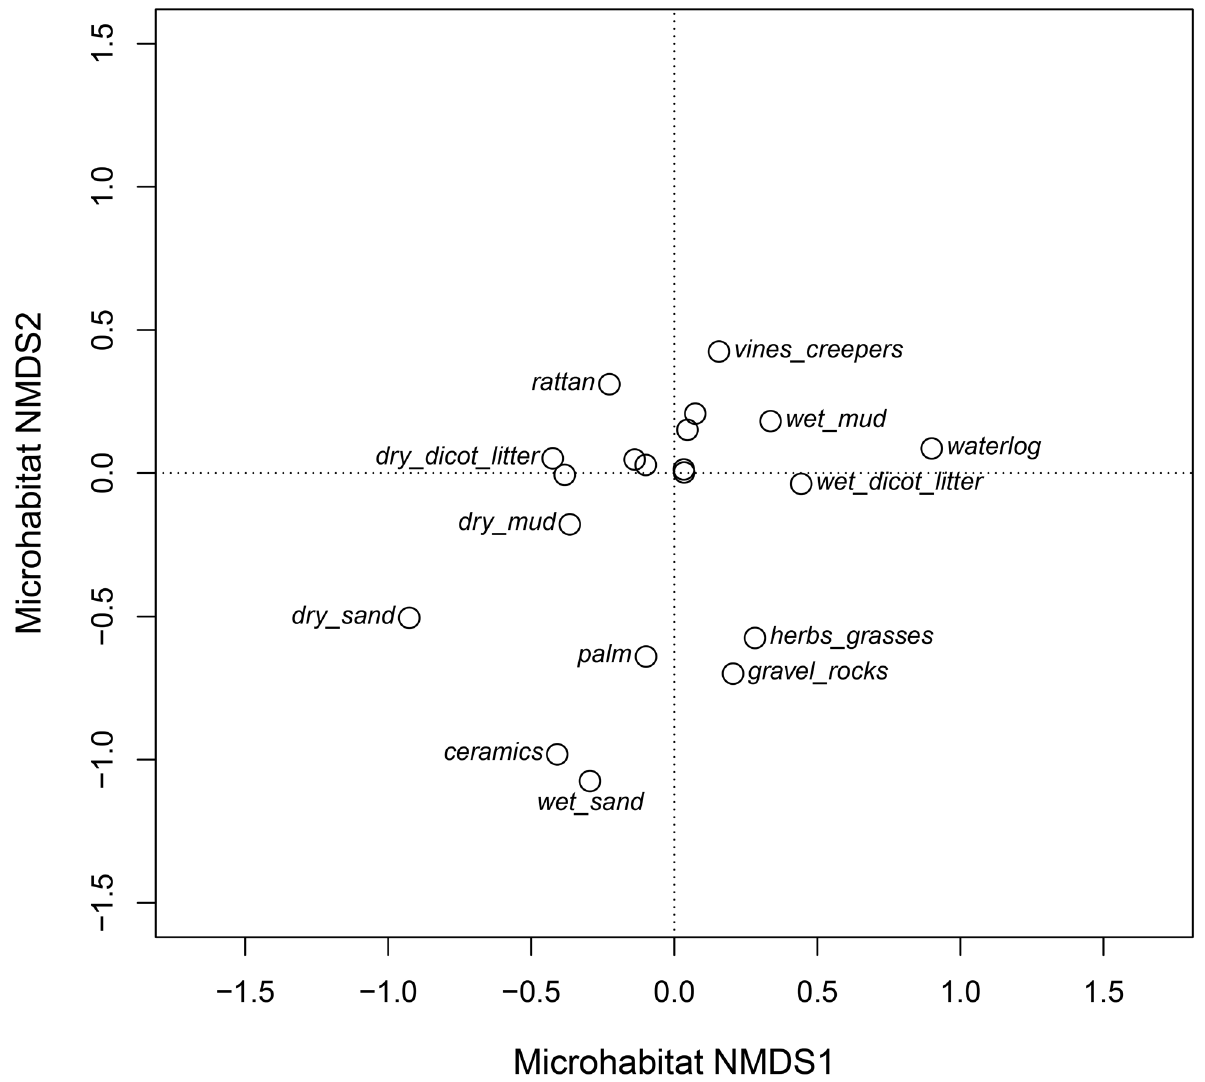
Figure 1. A non-metric multidimensional scaling (NMDS) using Bray-Curtis distance to summarize microhabitat condition data, indi- cating the different microhabitat conditions. Stress value for first two axes =